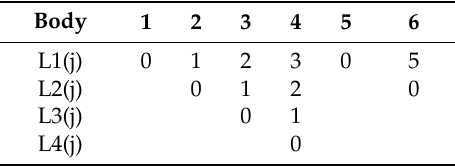
Table 2. Low-order-body Array of Chosen